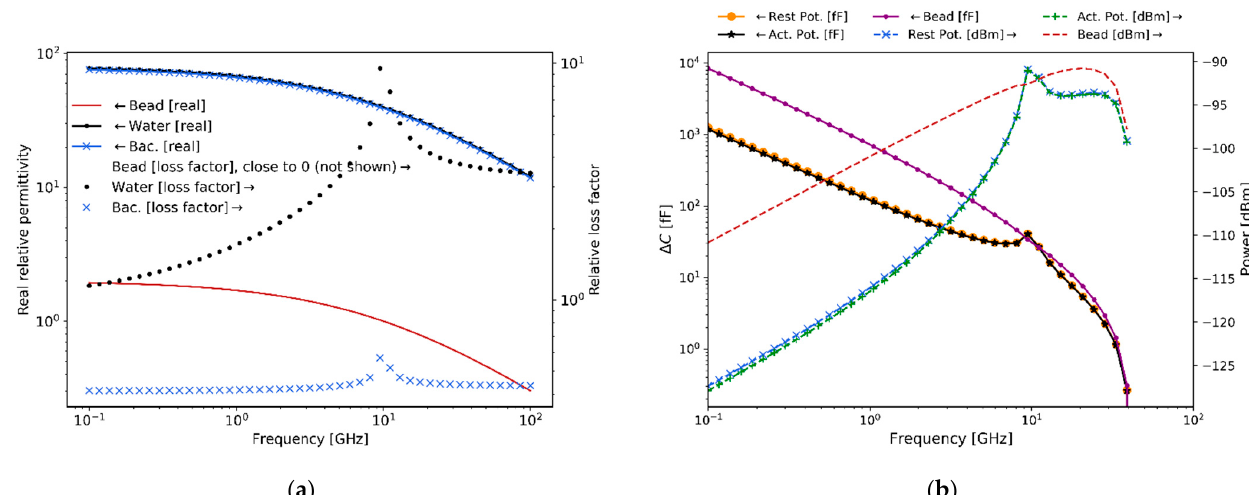
Figure 6. Microwave complex relative permittivity, expected capacitance change and scattering signal levels (near-field) for small 1 μm particles. ( a ) Complex relative permittivity values for the frequency range 0.1 − 100 GHz approximated from [29,34,52,53], with addition of (i) water, (ii) bacteria in an action potential process and (iii) polystyrene beads. ( b ) Expected capacitance change and scattering detection signal levels.